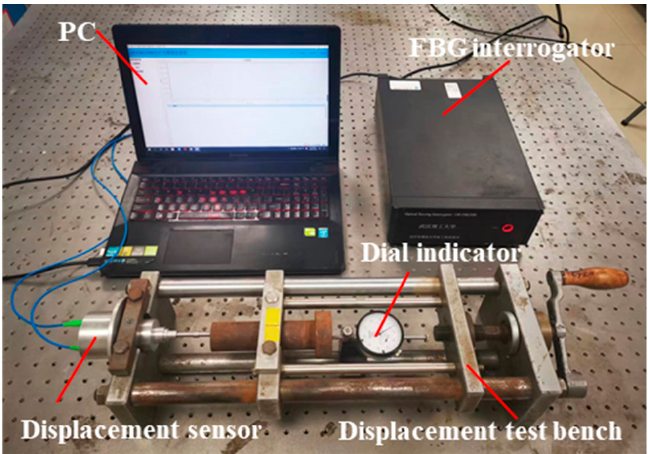
Figure 4. Displacement calibration experimental device.